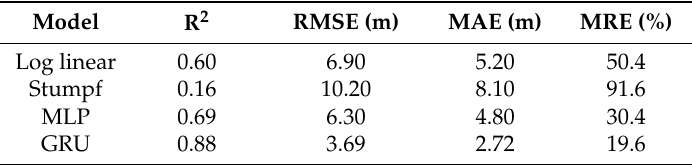
Table 2. The overall accuracy